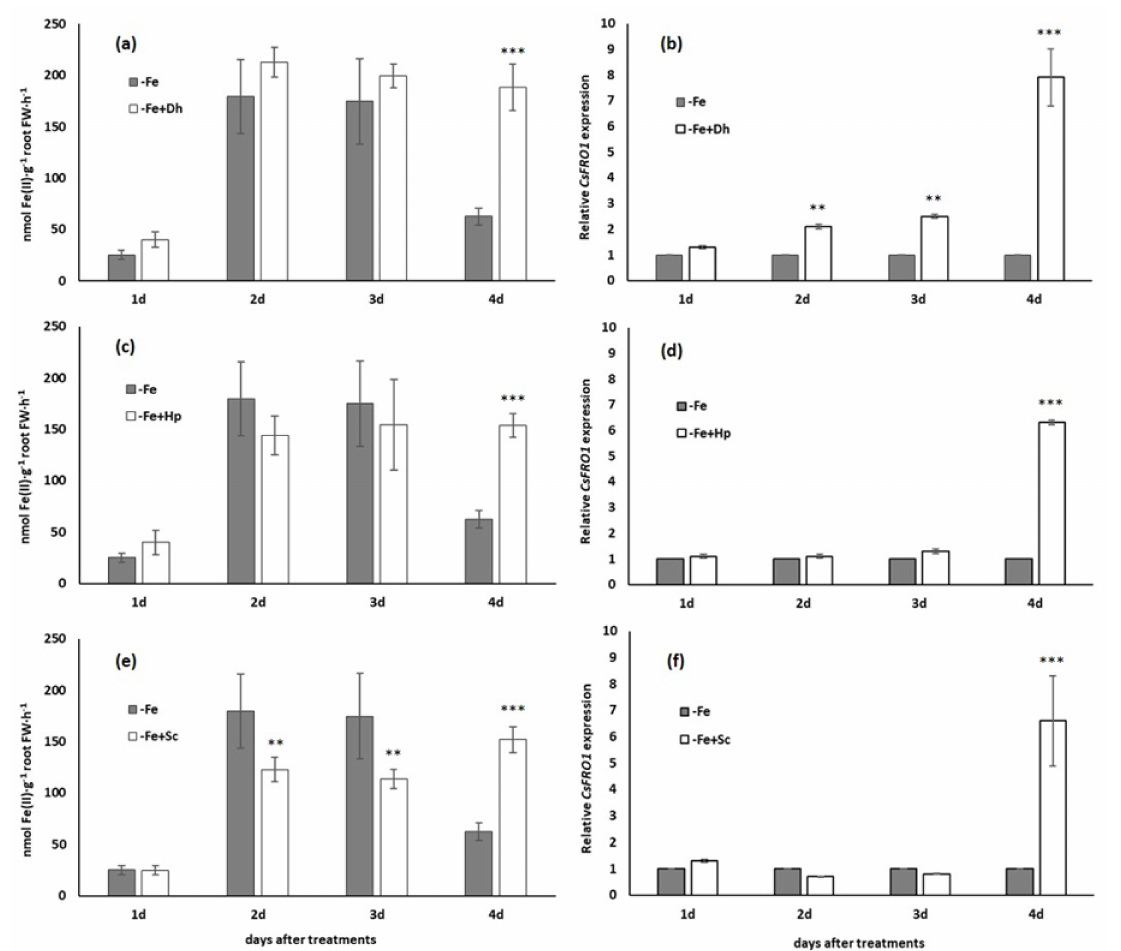
Figure 1. Time course of ferric reductase activity and CsFRO1 expression in cucumber plants along the 4 days of treatments. Treatments: nutrient solution without Fe (-Fe) and inoculation with the different yeast species, Debaryomyces hansenii ( − Fe+Dh) ( a , b ), Hansenula polymorpha (-Fe+Hp) ( c , d ), or Saccharomyces cerevisiae ( − Fe+Sc) ( e , f ). The inoculation was carried out the same day Fe-deficiency treatment was applied. The data of ferric reductase activity are given as means ± SE ( n = 6) while the data of CsFRO1 expression represent the mean ± SE of three independent biological replicates and two technical replicates. Within each day, bars with ** or *** indicate significant differences ( p < 0.01 or p < 0.001) in relation to the -Fe treatment according to the Dunnett’s